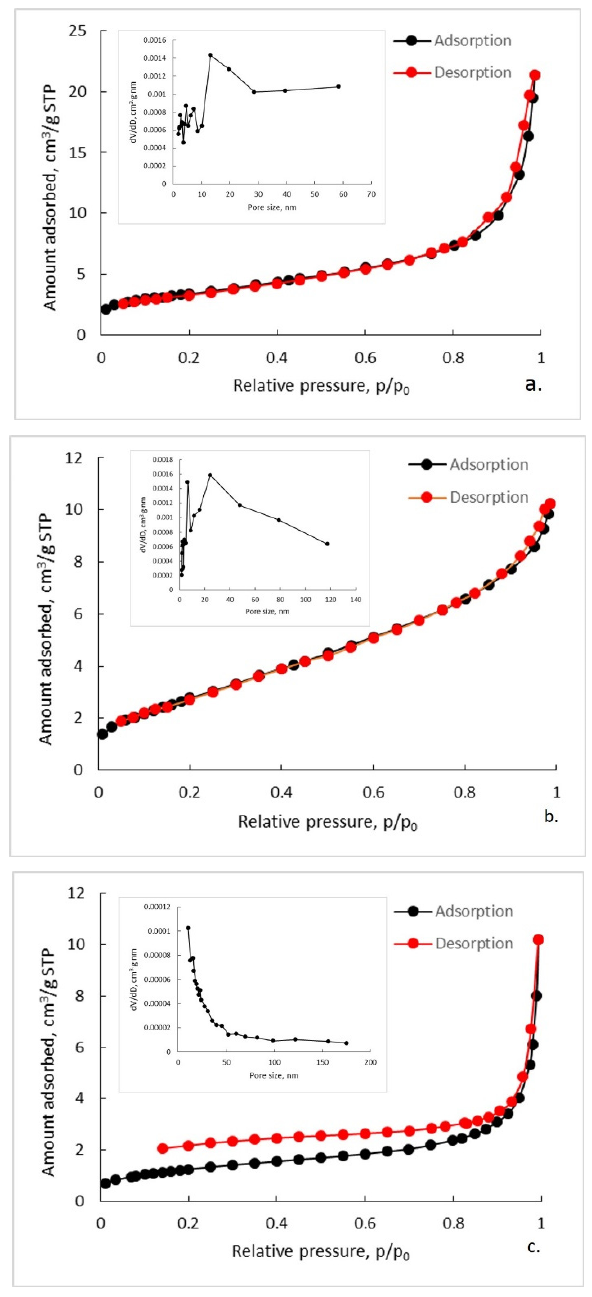
Figure 6. Nitrogen adsorption-desorption isotherms of of synthetized composites: ( a ) ZT-500, ( b ) ZT- Figure6. Nitrogenadsorption-desorptionisothermsofofsynthetizedcomposites: ( a )ZT-500, ( b )ZT-600, 600, ( c ) ZT-700. Particle size distribution as inset graphs. ( c ) ZT-700. Particle size distribution as inset